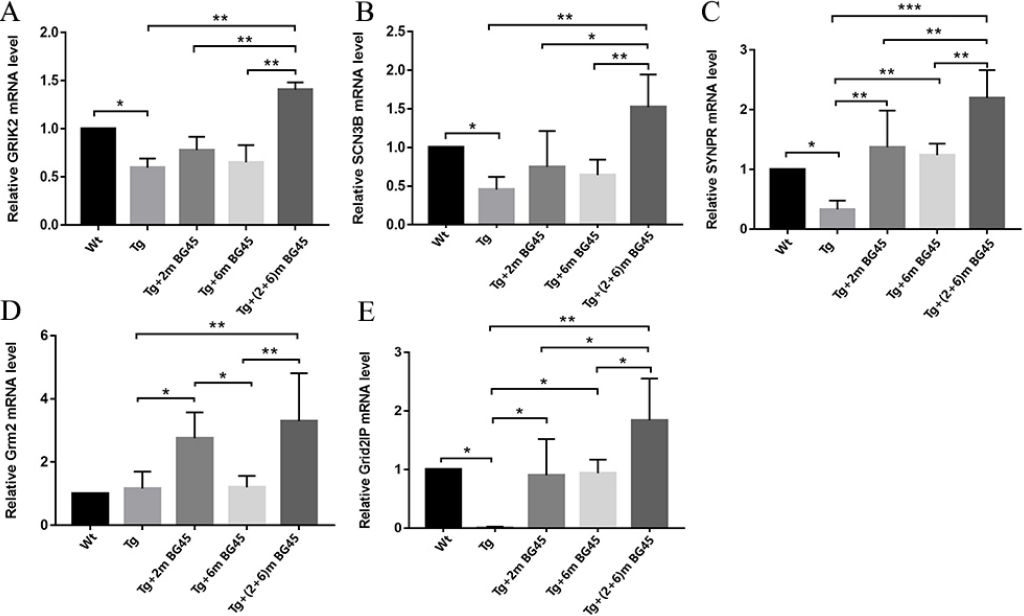
Figure 11. BG45 increased the levels of synapse-related genes (GRIK2, SCN3B, SYP, Grm2, and Grid2IP) in APP/PS1 mice ( n = 5). ( A–E ). GRIK2, SCN3B, SYP, Grm2, and Grid2IP mRNA